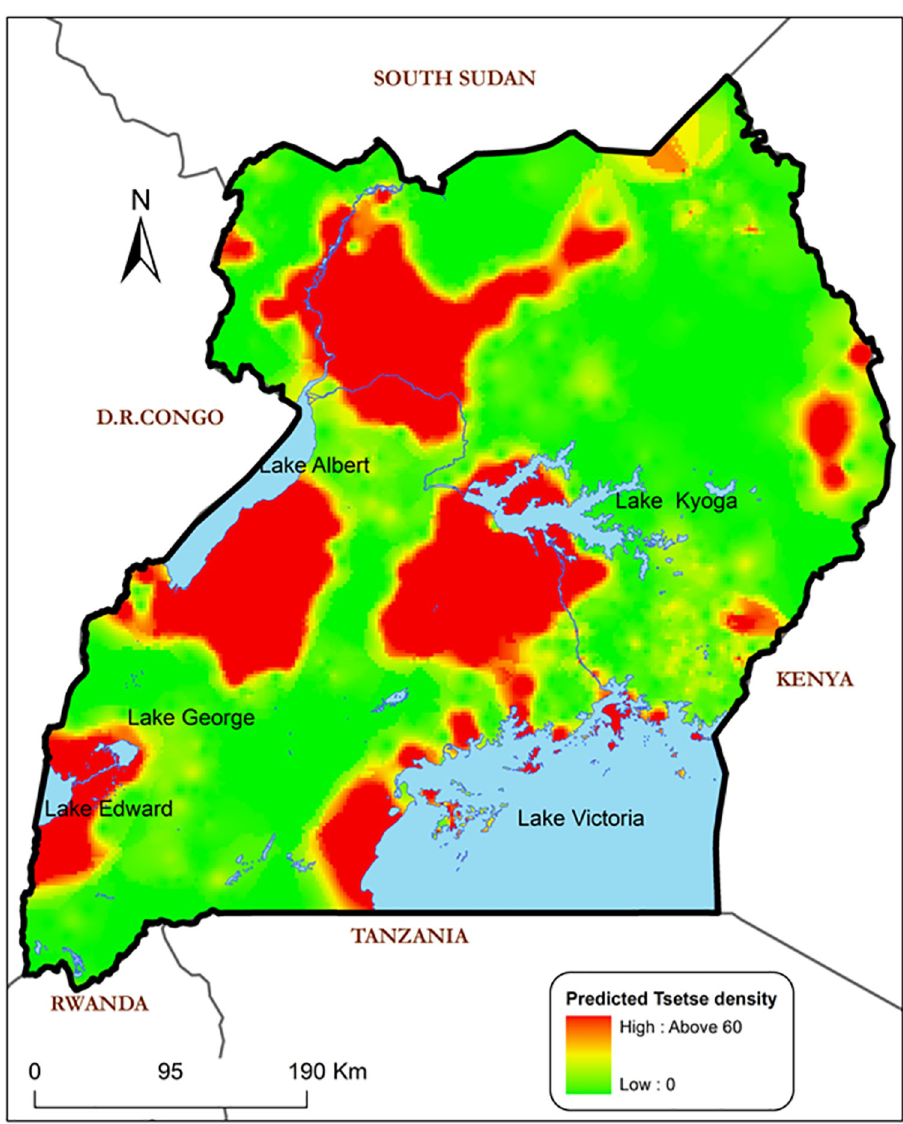
Fig 11. Predicted tsetse fly (Gff) abundance using the ZIP model. This tsetse prediction map is an output of the Zero-inflated Poisson regression model using R-tool and ArcGIS 9.1. Base map showing country boundaries of Uganda processed from GIS shapefiles obtained from the public domains https://data2.unhcr.org/en/documents/ details/83043.